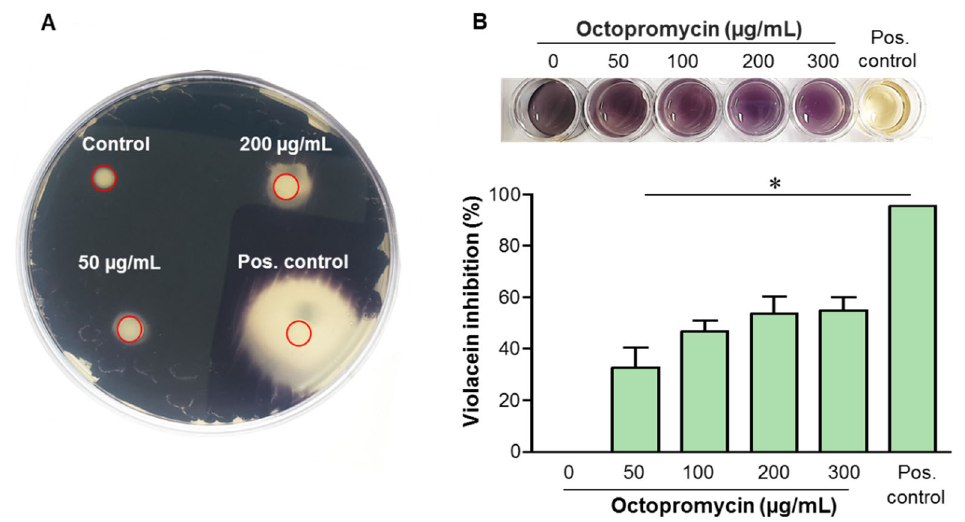
Figure 3. Inhibition of violacein production by octopromycin ( A ) Quorum-sensing bioassay results. The plate shows representative results of inhibition of violacein production by octopromycin at MIC (50 μ g/mL), MBC (200 μ g/mL), and positive (Pos.) control (CHL 100 μ g/mL). The absence of purple pigment formation was considered to indicate a potential QS inhibitor. ( B ) Representative series of images of violacein production by C. vialaceum treated with 0–300 μ g/mL of octopromycin by the microtiter plate method. The bar graph presents the quantitative results of the inhibition of N ‐ [3 ‐ oxohexanoyl] ‐ l ‐ homoserine lactone (OHL) ‐ mediated violacein production. * p ≤ 0.05 compared to the control group. The error bars indicate mean ± standard deviation ( n = 3).